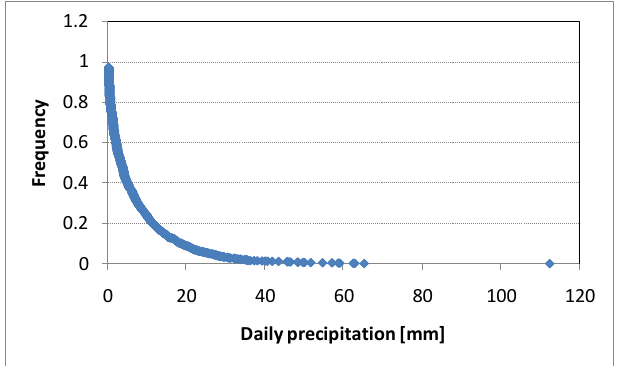
Figure 6. Wastewater daily patterns. 2.2.2. Green Roofs Green roofs, also known as vegetated roof covers or living roofs, are a complex multilayer structure. They are mostly used in the case of retrofitting of existing buildings due to their low weight and minimal maintenance requirements. The long-term modeling of green roofs was carried out following the guidelines and the parameters presented by Cipolla et al. [16]. An extensive green roof package with 15 cm of substrate was located above the roof building. Evapotranspiration was modeled using the maximum and minimum daily air temperature and following the Hargreaves– Samani formulation [28]. 2.2.3. Rainwater Harvesting Systems (RWHSs) RWHSs allow the collection and the reuse, for nonpotable purposes, of rainwater; thus, their first goal is the reduction of conventional water withdrawal. However, as they retain important volumes of precipitation, they also pursue a secondary goal which consists of the reduction of runoff. In this study, RWHSs were sized according to the Italian UNI/TS 11,445 regulation [29], while their long-term behavior was modeled according to the procedure proposed by Cipolla et al. (2018a) [30].